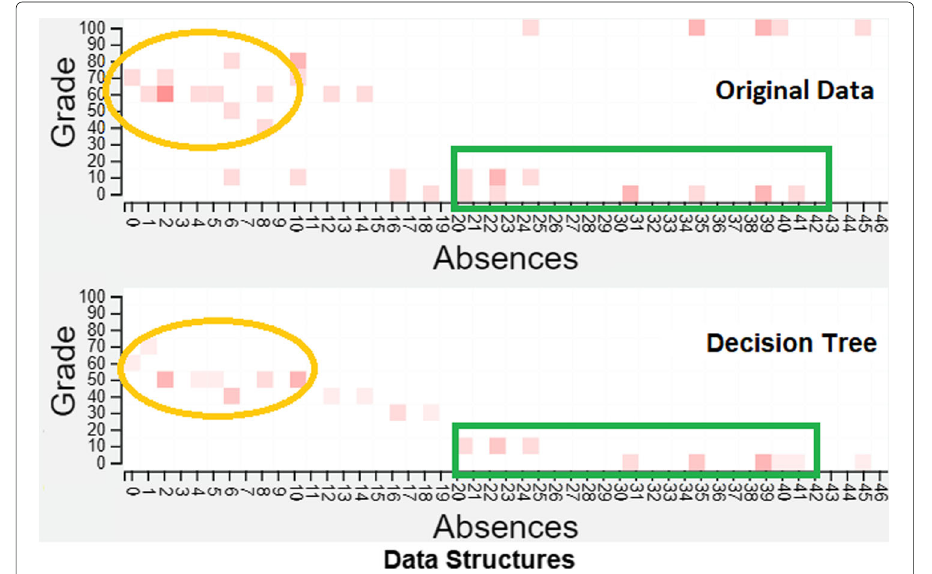
Fig. 15 Data Structures: Original data vs. Decision Tree